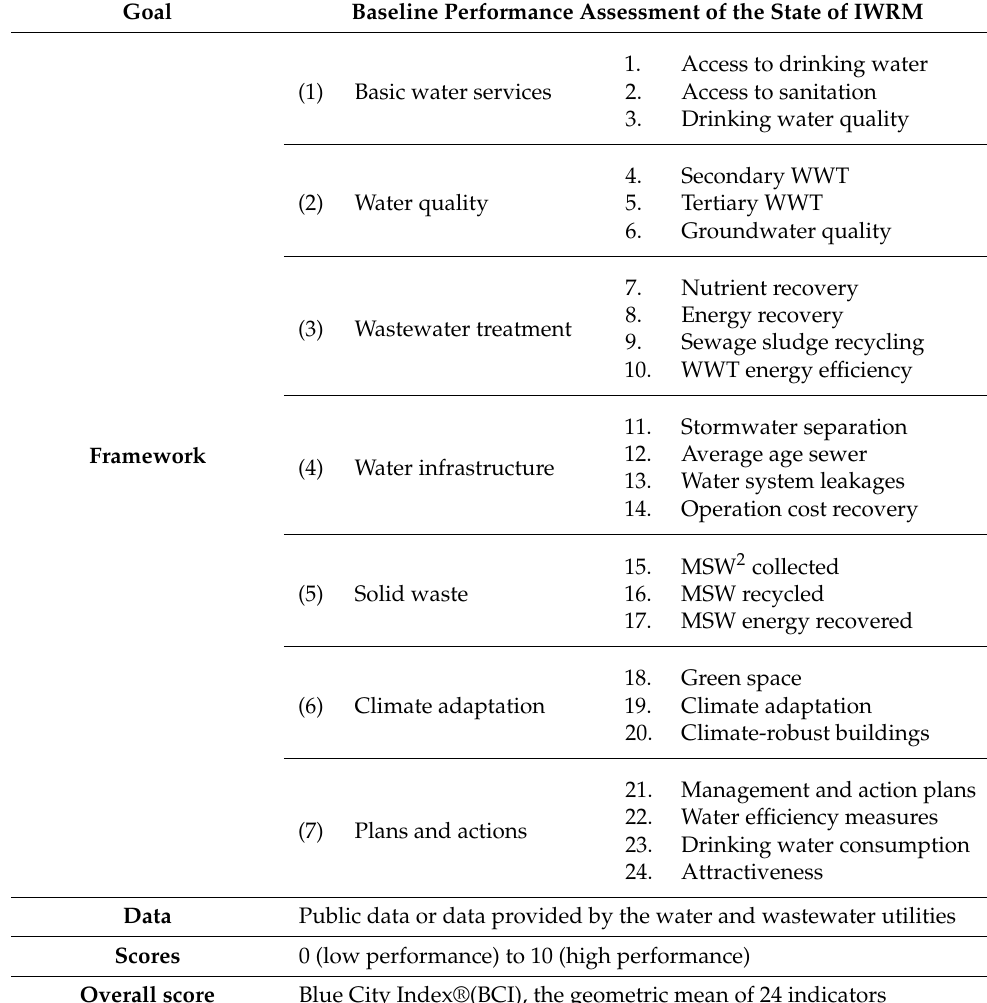
Table 1. City Blueprint Framework [15]. WWT, wastewater treatment; IWRM, integrated water resources management; MSW, municipal solid